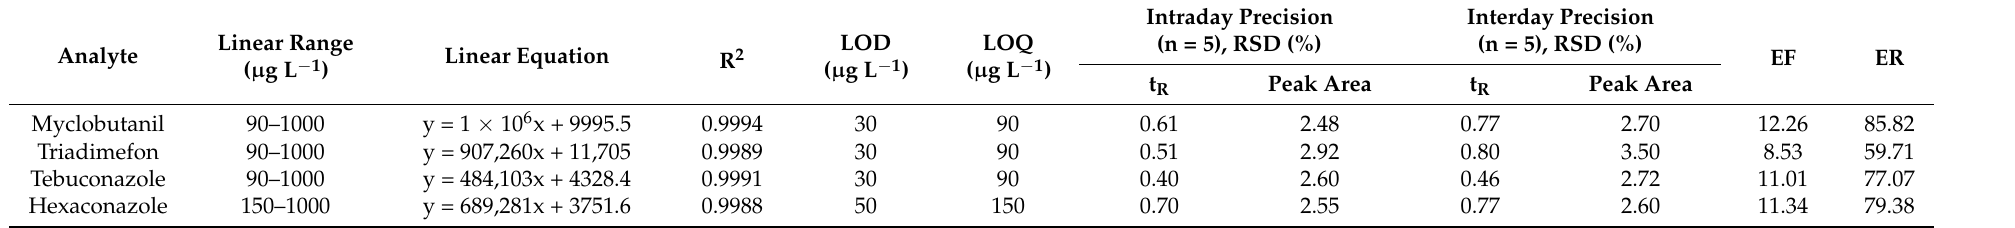
Table 1. Analytical performance of the proposed